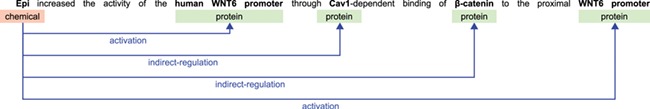
Example sentence illustrating biochemical entities and their relations.